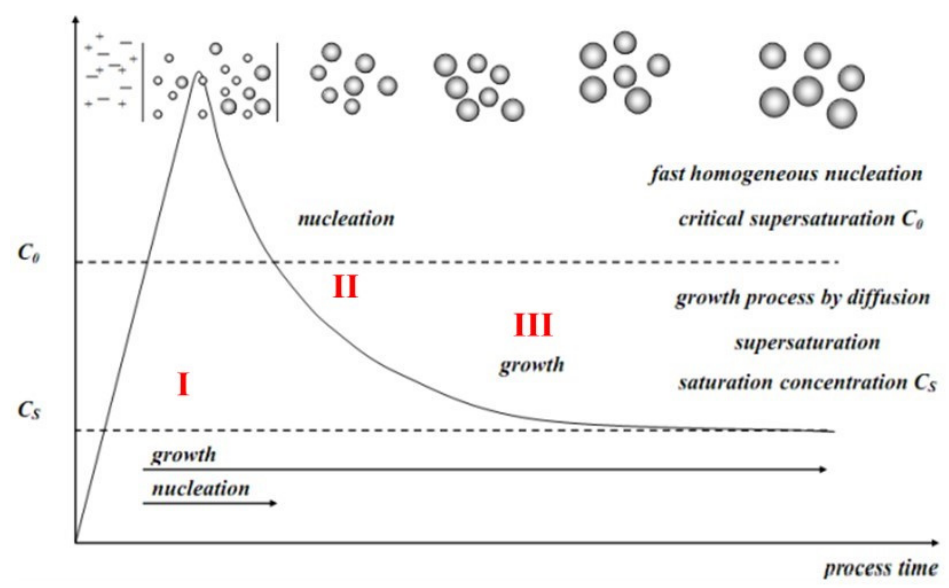
Figure 8. LaMer and Dinegar mechanism for monodisperse nanoparticles growth Adapted with permission from [78]. Copyright, 2016 American Chemical Society.